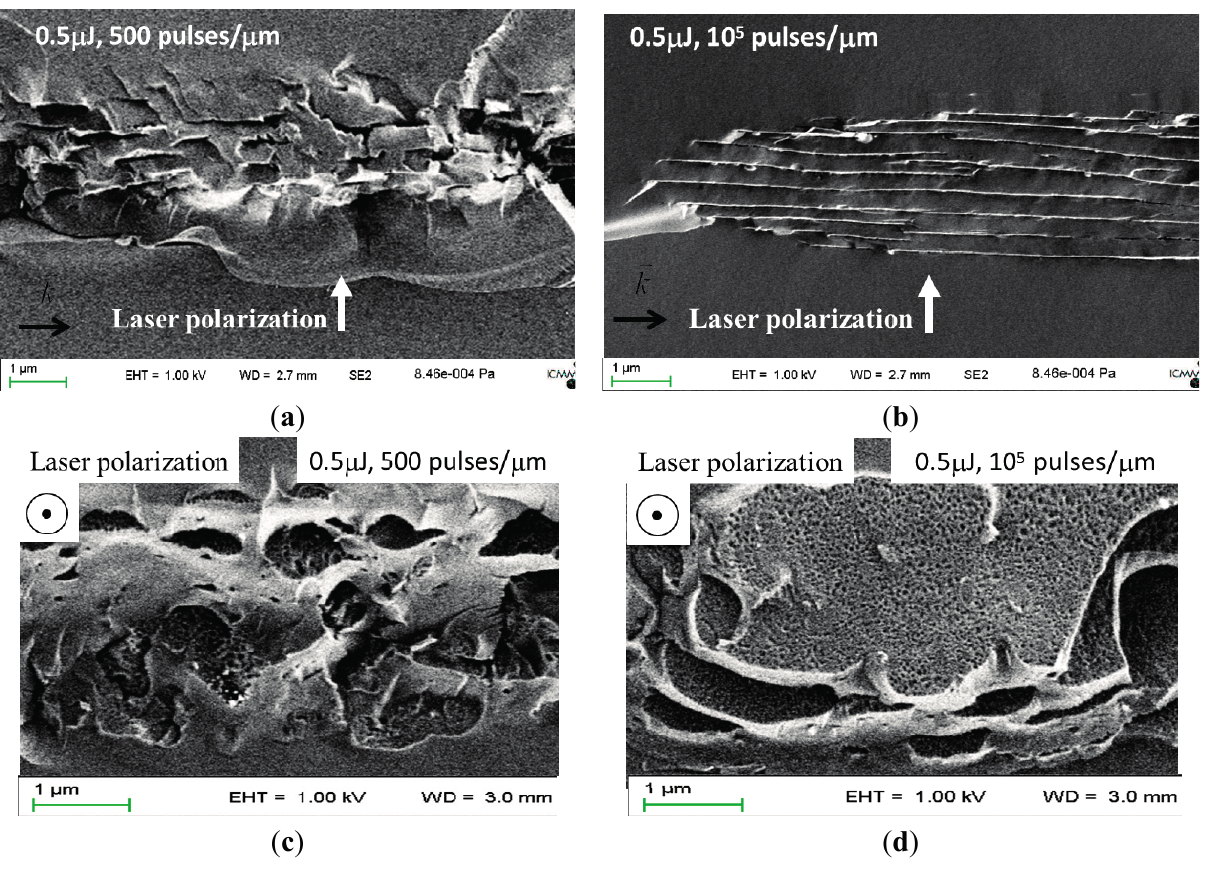
Figure 1. FEG-SEM (Field-Emission Gun Scanning Electron Microscope) secondary electron images of laser track cross-section for the writing laser polarization ( a , b ) perpendicular to the scanning direction and ( c , d ) parallel to the scanning direction. The laser parameters were: 0.5 μ J/pulse, 1030 nm, 300 fs and 500 kHz. A focusing aspheric lens of 0.6 NA was